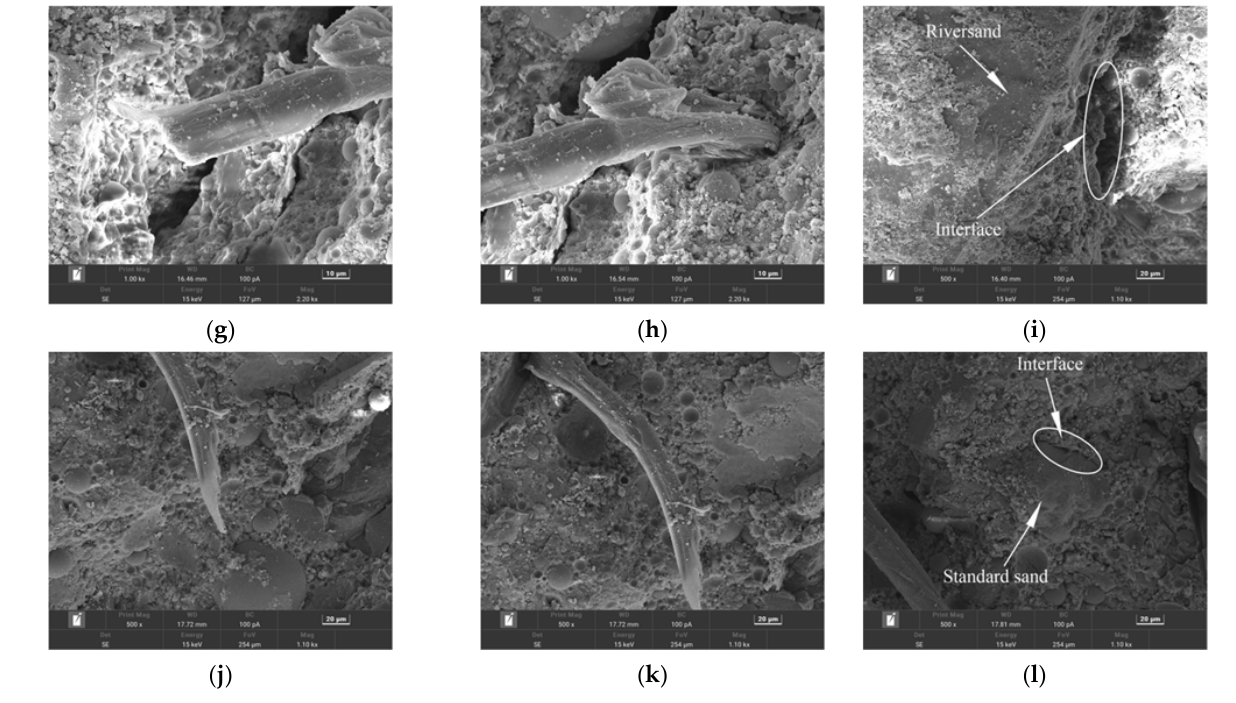
Figure 6. ECC microstructure of different fine aggregates.